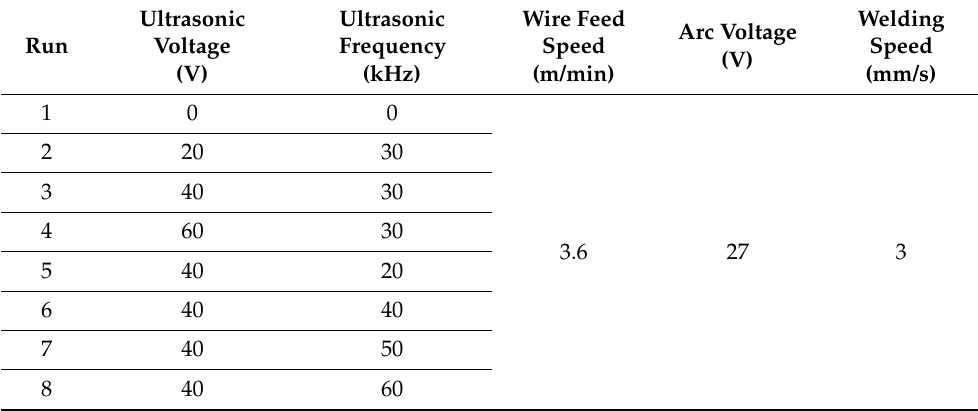
Table 2. Parameters of ultrasonic-frequency pulse underwater wet welding.